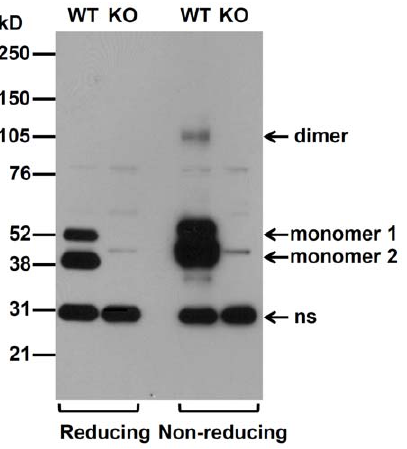
Figure 3. RAGE from mouse lung also exhibits disulfide-bond mediated dimeric structure. The lungs were isolated from both wild-type and RAGE(KO) mice and crude membrane fraction was prepared. The extracted membrane protein lysates (15 m g) were then resolved on SDS-PAGE (4–12% gradient gel) under reducing and non- reducing conditions followed with immunoblotting by anti-RAGE antibodies. ns, major non-specific protein species. Monomeric and dimeric forms are